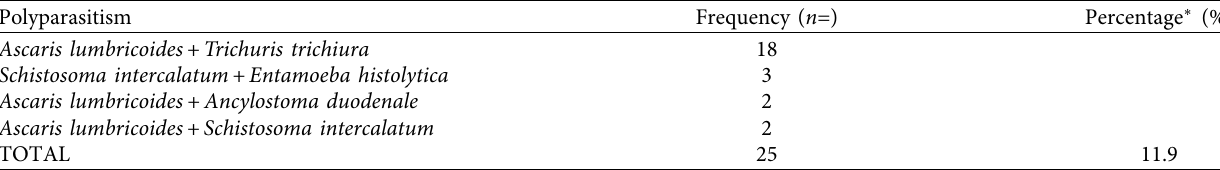
Table 3: Polyparasitic infections (coinfection of two or more parasite species in the same pregnant women). Polyparasitism